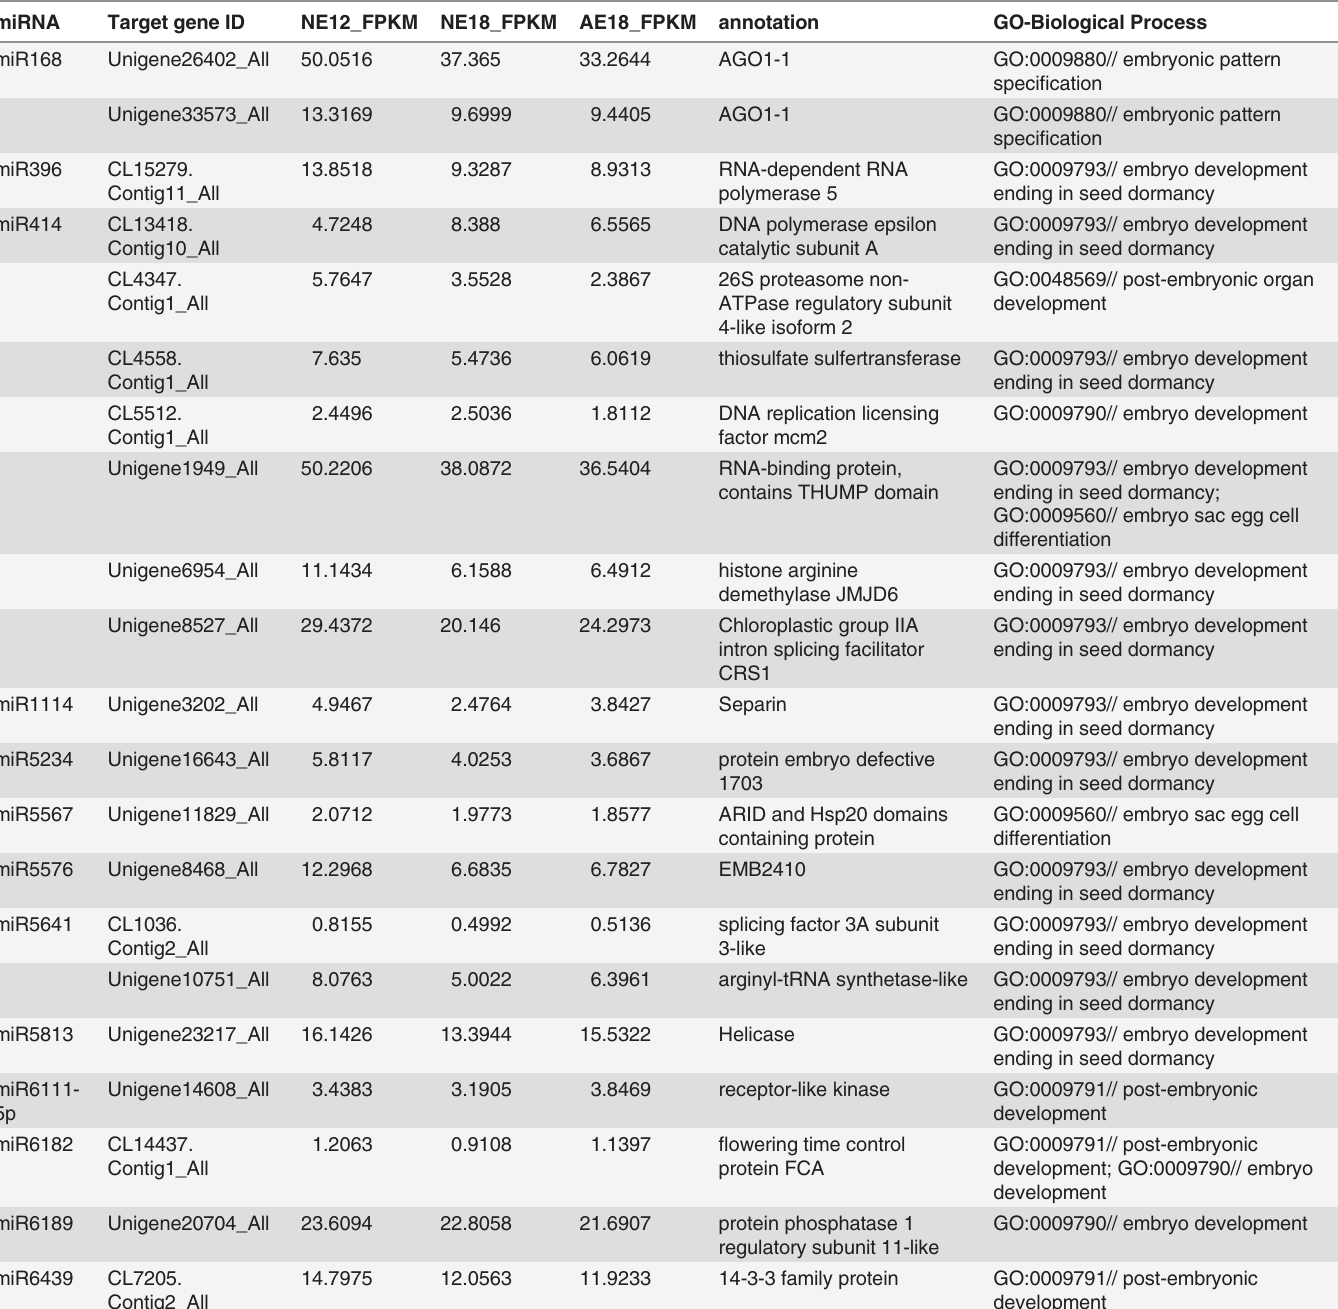
Table 4. Identified candidate miRNA targets associated with embryo